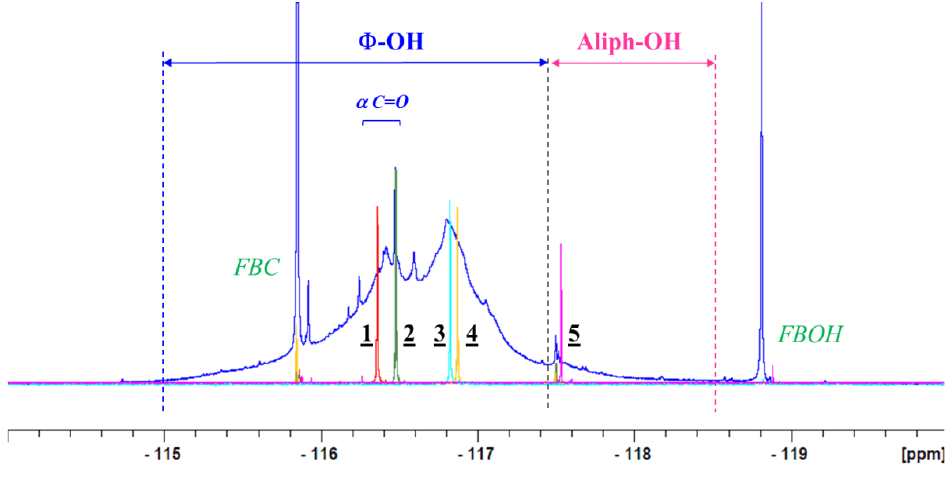
Figure 7. Comparison of 19 F-NMR spectra of fluorobenzylated ORG lignin (in blue) and derivatized model compounds. (Note: Only phenol derivatization for 4 ). Table 6. Comparison of phenolic hydroxyl groups (mmol/g) for Organosolv lignin using 19 F-NMR and other techniques [10].